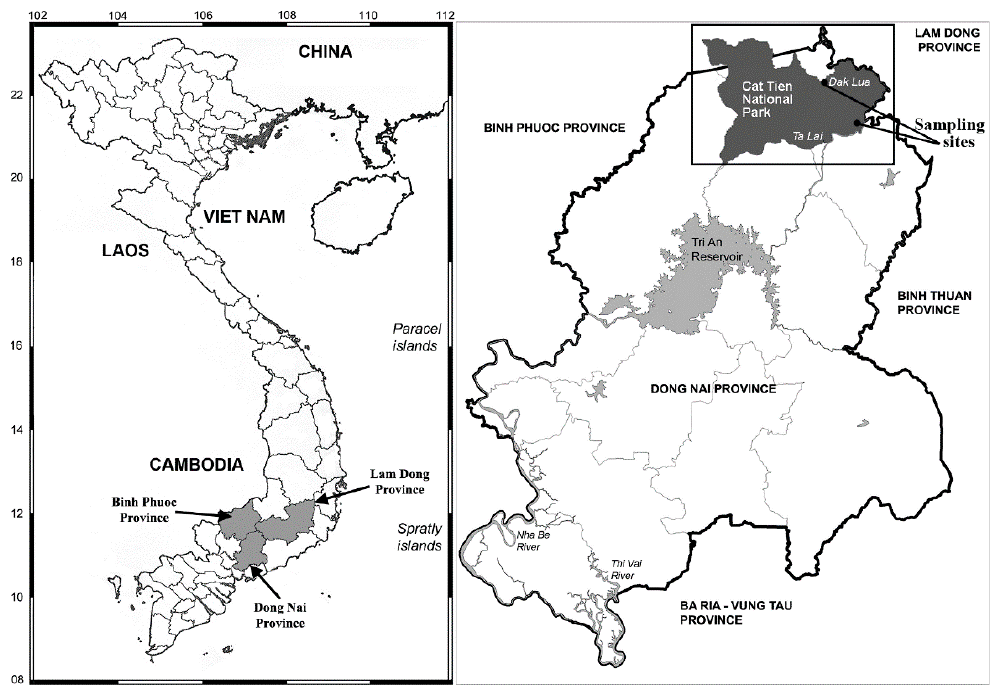
Figure 1. Map of the study area.